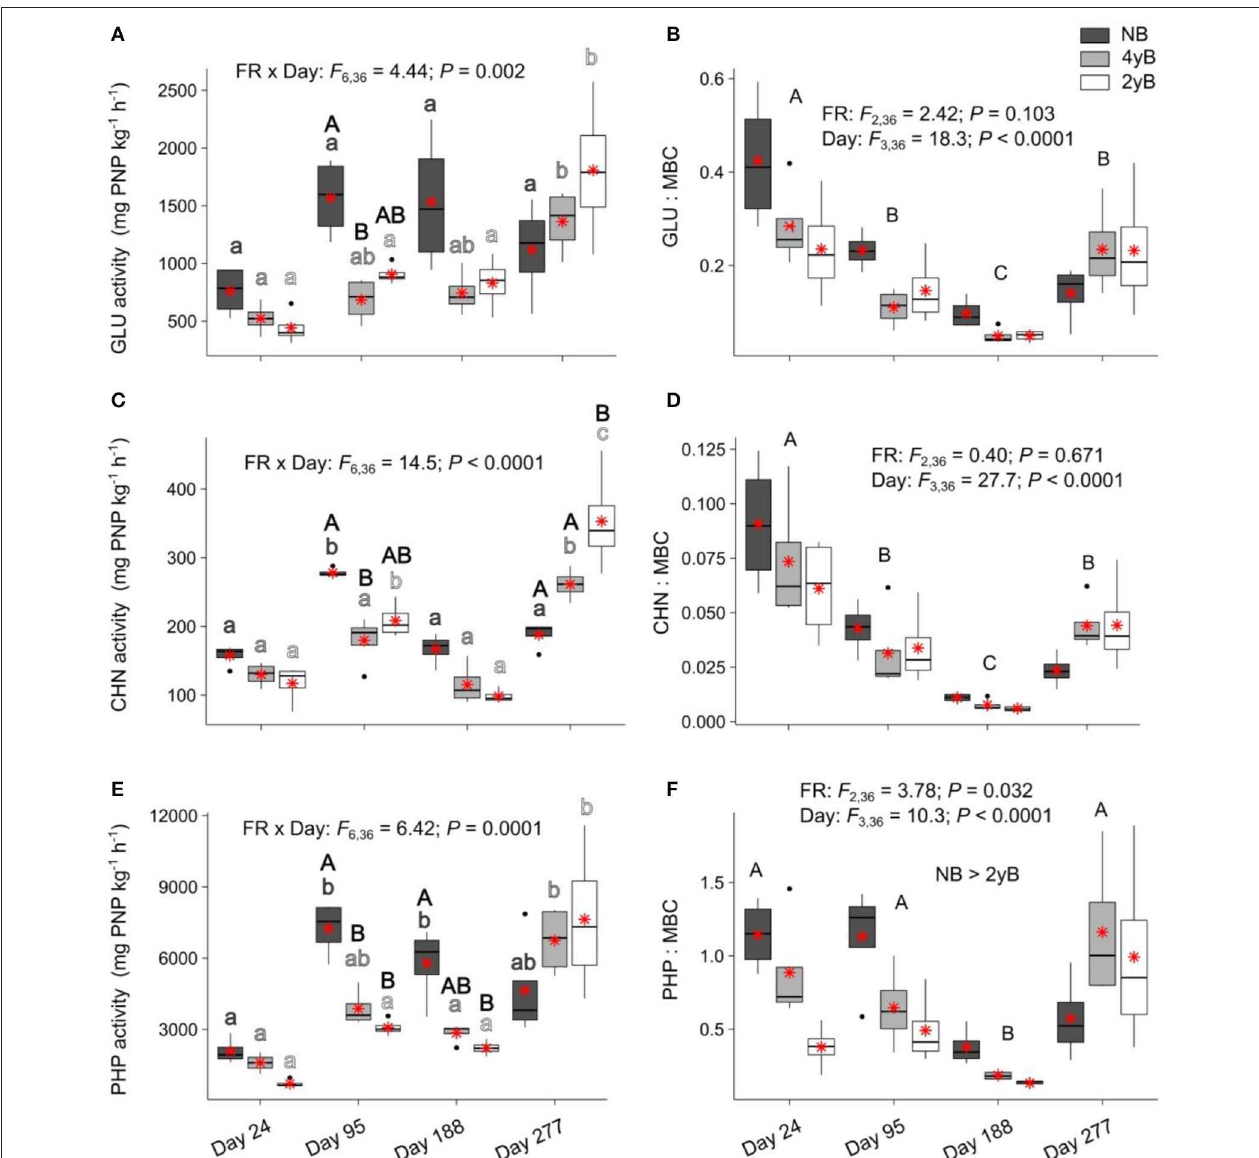
FIGURE 7 | Potential activities of (A) β -glucosidase (GLU), (B) GLU relative to microbial biomass carbon (GLU:MBC), (C) chitinase (CHN), (D) CHN relative to MBC (CHN:MBC), (E) acid phosphatase (PHP), and (F) PHP relative to MBC (PHP:MBC) compared among dates and fire regime treatments (NB = no burning; 4yB = four-yearly burning; 2yB = two-yearly burning); means are displayed as red asterisks; results of two-way factorial analysis of variance and Tukey’s Honestly Significant Difference post-hoc comparisons of treatment combination means shown (different lowercase letters of the same color indicate significant differences among date means for a given fire regime treatment, different uppercase letters indicate significant differences among fire regime means for a given date for panels A , C , and E , and among dates for panels B , D , and F